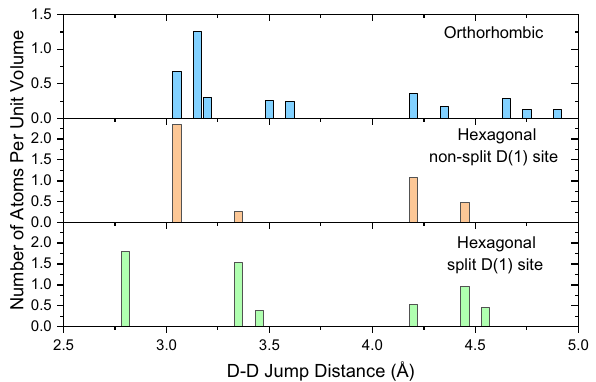
Figure 4. Deuterium-deuterium distances reported from neutron diffraction data for BaD 21 . The orthorhombic and hexagonal phases were measured at T = 670 K and 883 K, respectively. The hexagonal phase distances are calculated for the D(1) atoms residing on the non-split 2d sites and split 4f. sites.